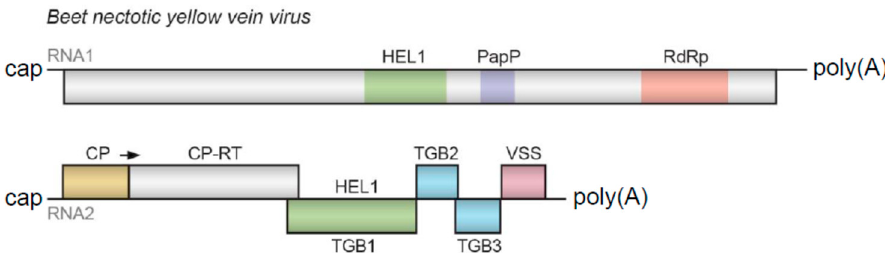
Figure 1. Gene organization of principal RNA genomic components of Beet necrotic yellow vein virus . Genes are shown as boxes with the names of the encoded proteins. Domains of RNA replicase ORF encoded by RNA1 include helicase superfamily 1 (HEL1), papain protease (PapP) and RNA-dependent RNA polymerase core domain (RdRp). Genes of proteins potentially involved in cell-to-cell movement (TGB) are shown in green and blue. VSS—virus silencing suppressor; CP-RT—capsid protein read-through protein.